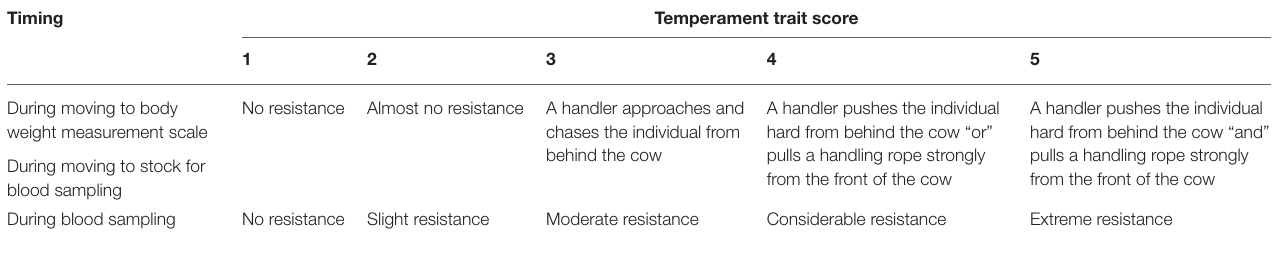
TABLE 2 | Definition of temperament trait